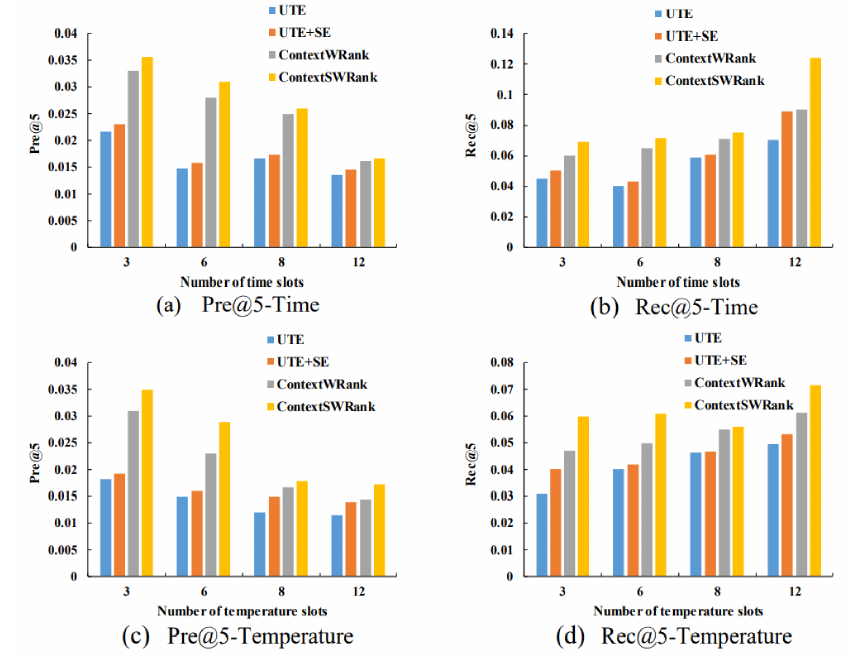
Figure 6. Performance comparisons with different numbers of context